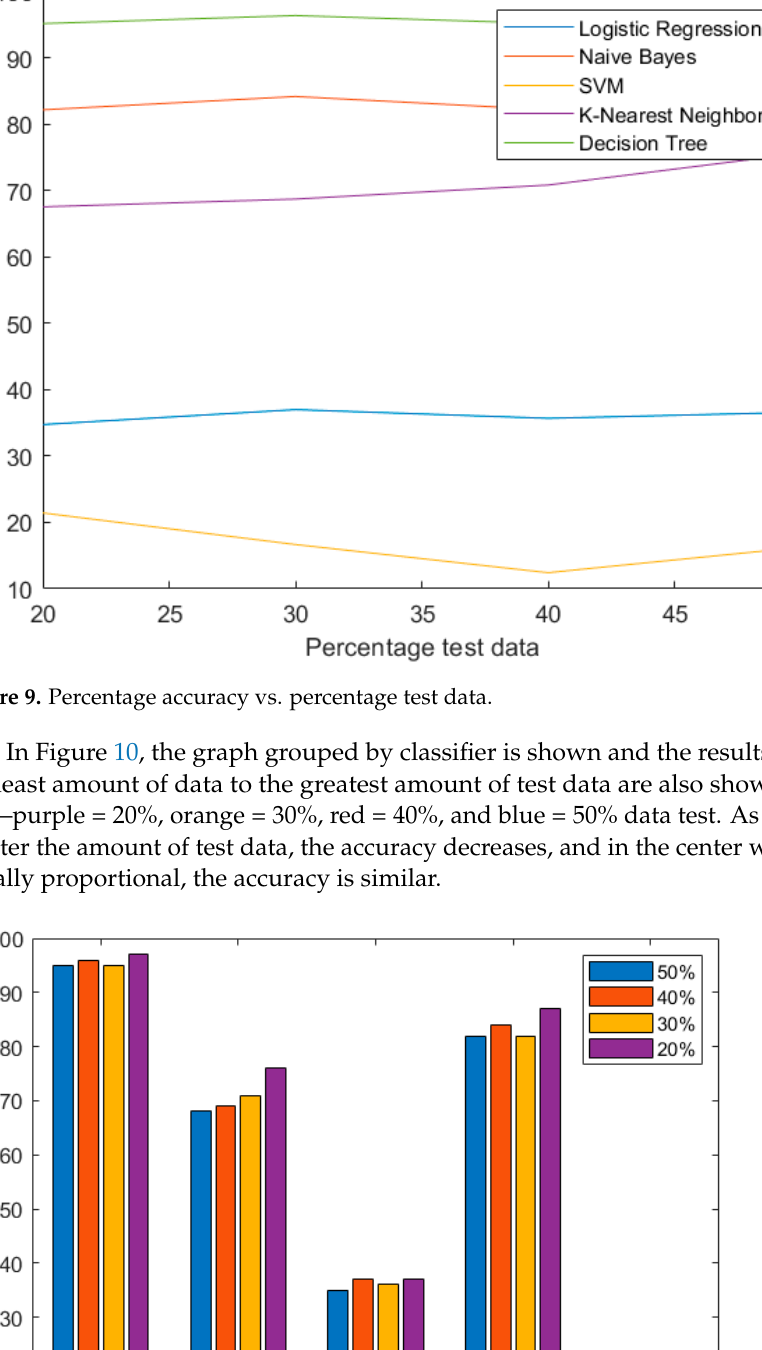
Figure 9. Percentage accuracy vs. percentage test data.